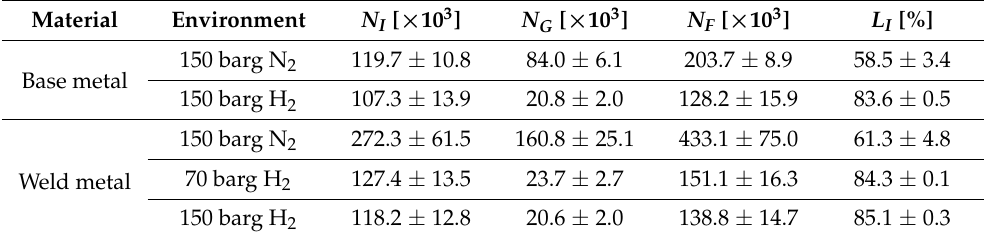
Figure 6. Bar graph of the number of cycles spent in the crack initiation phase ( N I ) and the growth phase ( N G ), and the total number of cycles until failure ( N F ) of the weld metal specimens. The different environments tested are shown with distinct colors. The single and double hatched bars represent the number of cycles spent in the initiation and growth phase, respectively. Error bars are standard deviations. Table 4. An overview of the pressurized base and weld metal fatigue results presenting the number of cycles spent in the crack initiation phase ( N I ), the growth phase ( N G ), the cycles until failure ( N F ) and percentage of lifetime spent in the crack initiation phase ( L I ). Errors are standard